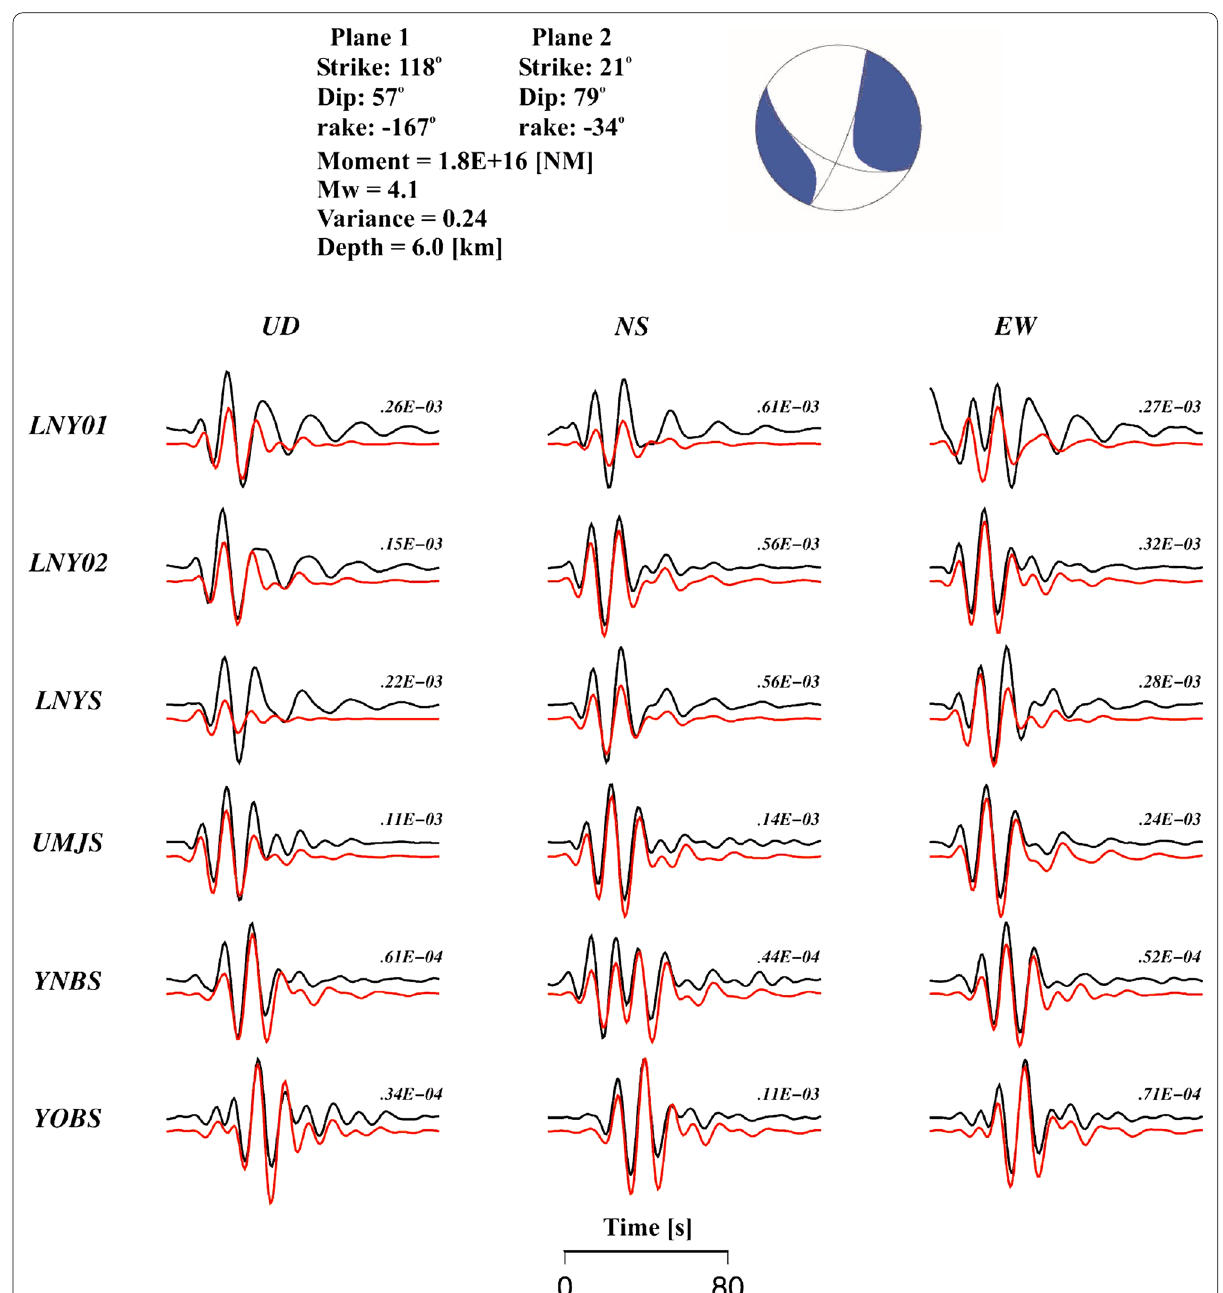
Fig. 9 Plot showing the focal mechanism solutions and a comparison between the observed and synthetic seismograms computed for the deviatoric solution as derived from the waveform